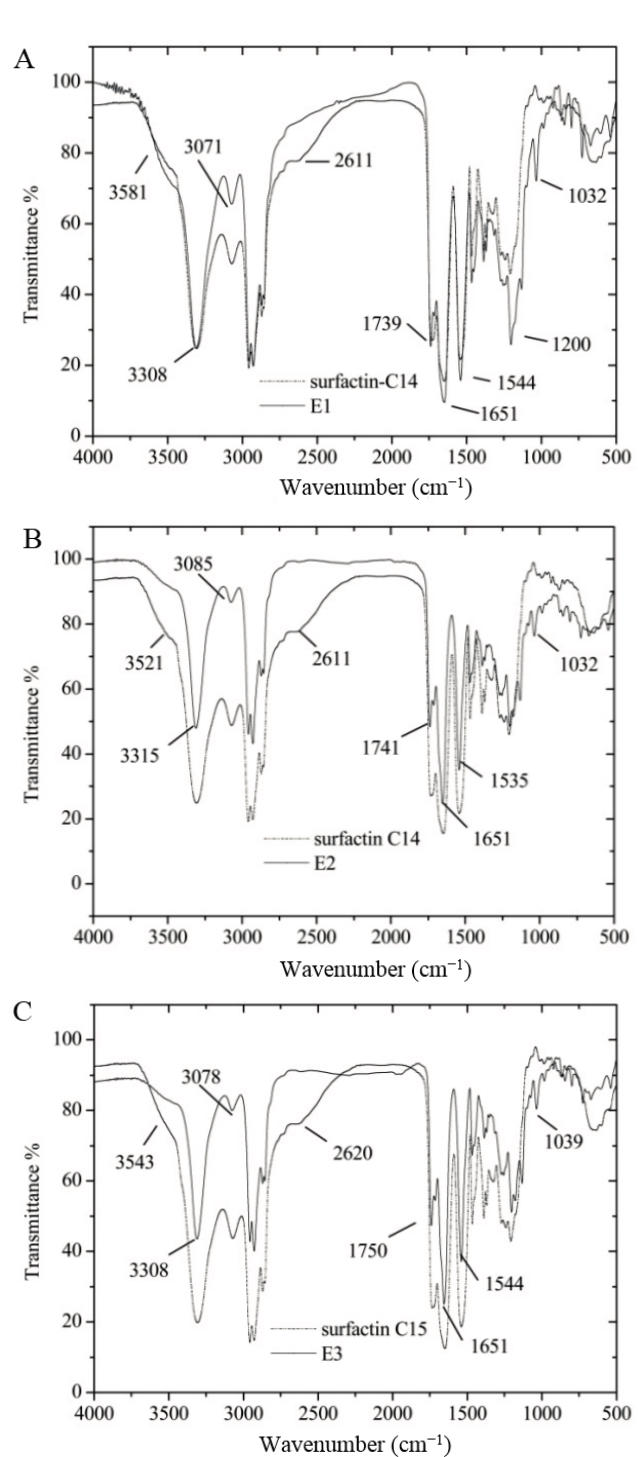
Figure 7. FT-IR spectra of E1, E2 and E3. ( A ) for the surfactin-C14 and mono-2-methoxy- ethyl-surfactin-C14 ester (E1); ( B ) for the surfactin-C14 and di -2-methoxy-ethyl-surfactin C14 ester; and ( C ) for surfactin-C15 and di -2-methoxy-ethyl-surfactin C14